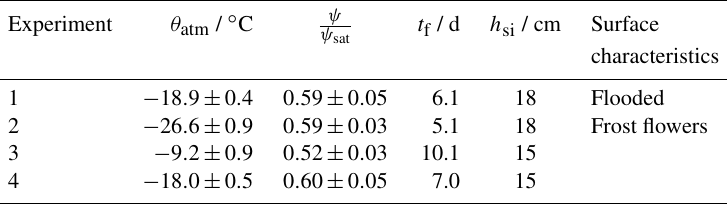
Table 2. Overview of experiments used to calculate with PAR extinction coefficients. θ atm gives the mean atmospheric temperature during the experiment. ψ is the mean relative humidity during the experiment, with ψ representing humidity and the subscript sat indicating ψ sat saturation. t f gives the duration of the freeze up period. h si gives the maximum thickness attained, at which point κ was measured.